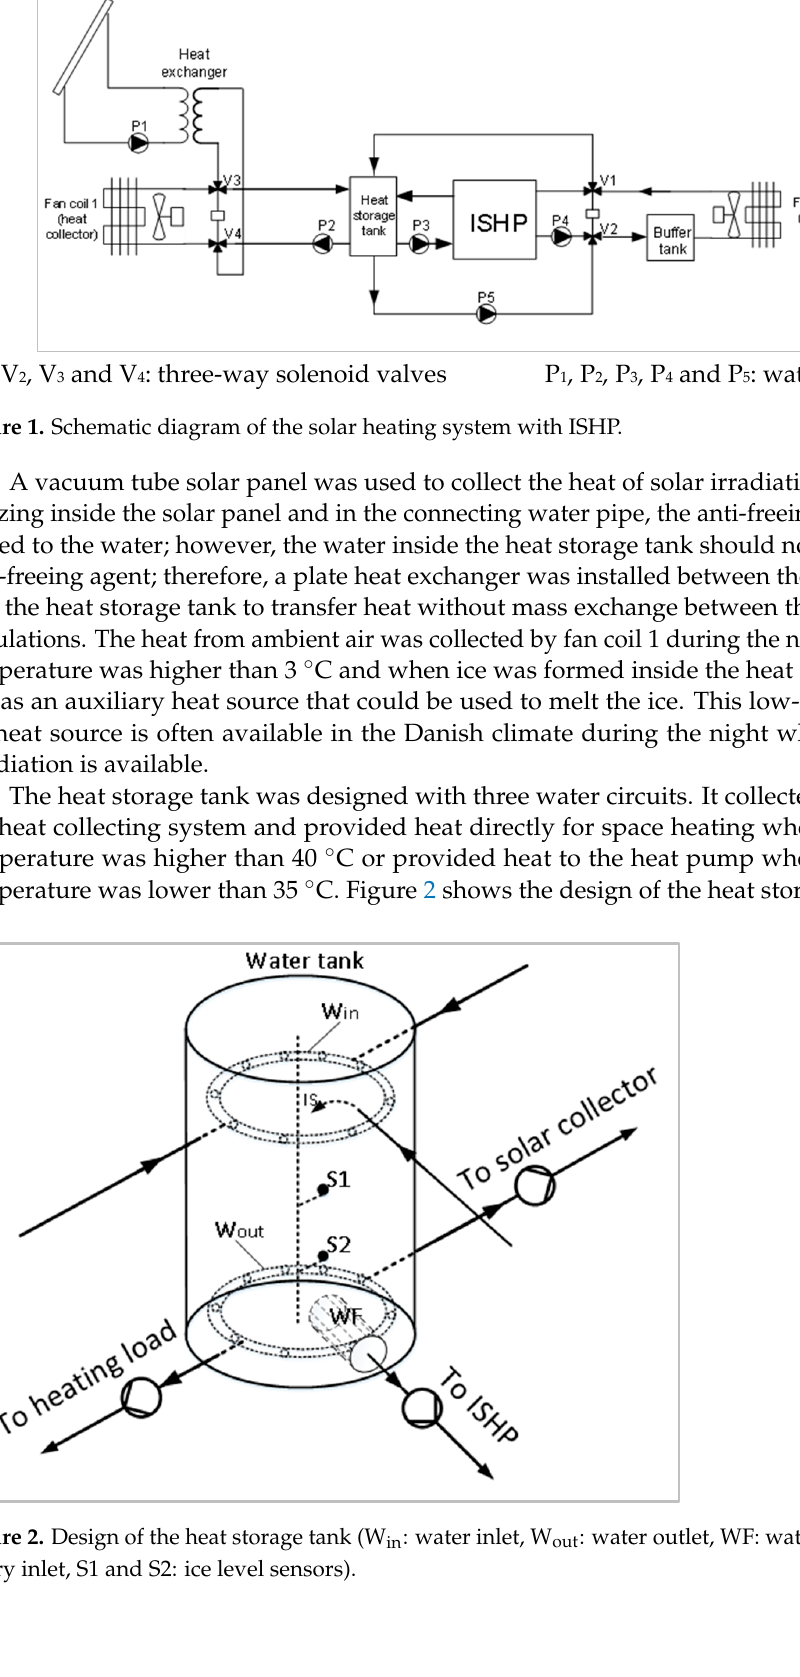
Figure 2. Design of the heat storage tank (W in : water inlet, W out : water outlet, WF: water filter, IS: ice slurry inlet, S1 and S2: ice level sensors).